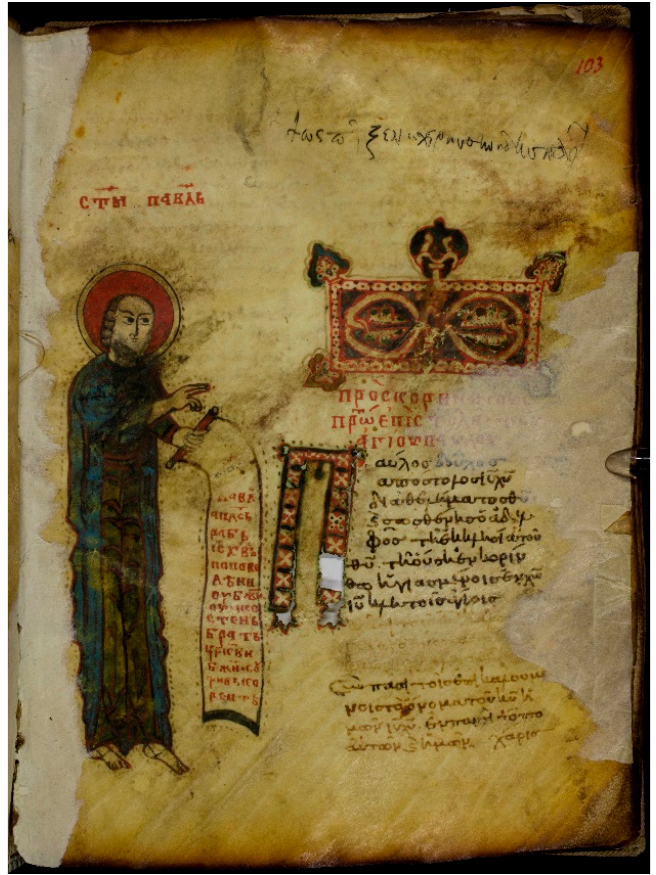
Figure 5. Miniature of the Apostle Paul. National Library of Greece. EBE 149, f. 103r (GA 1875). Ca. 10th century CE. Image used by permission from the National Library of Greece and the CSNTM. The image of Paul before 1 Timothy at 143r, however, is slightly different (Figure 6).